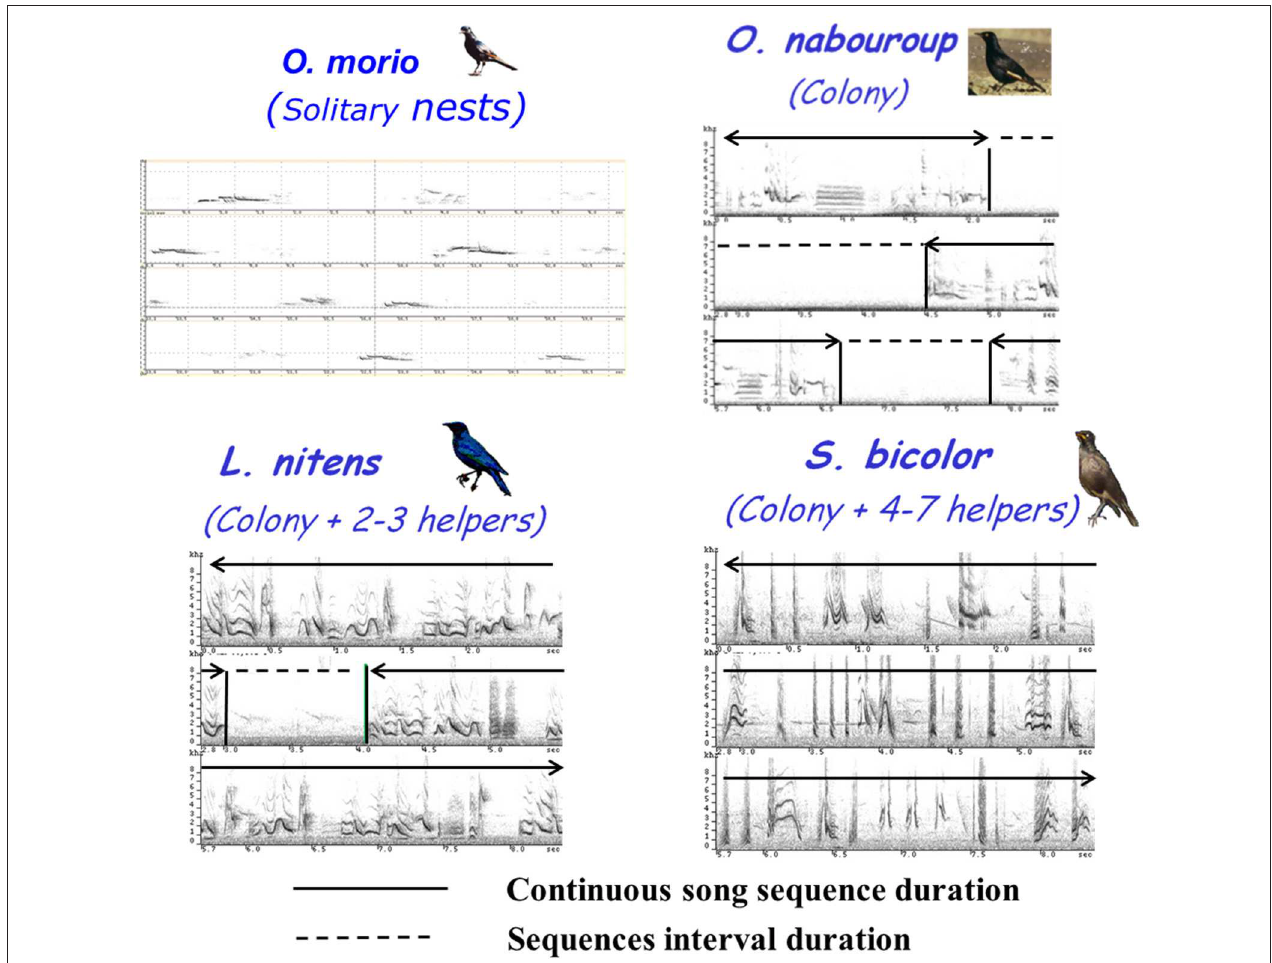
FIGURE 11 | Song sequence duration and sequence interval duration for the 4 species of African